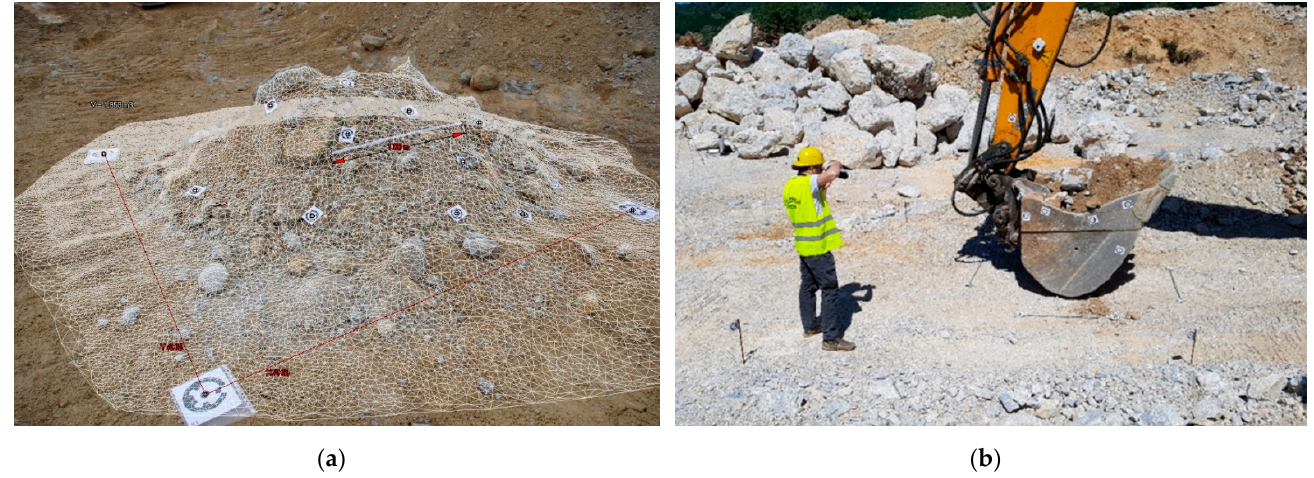
Figure 2. (a) Measuring volume of the bucket load and ( b ) angle of repose of material.